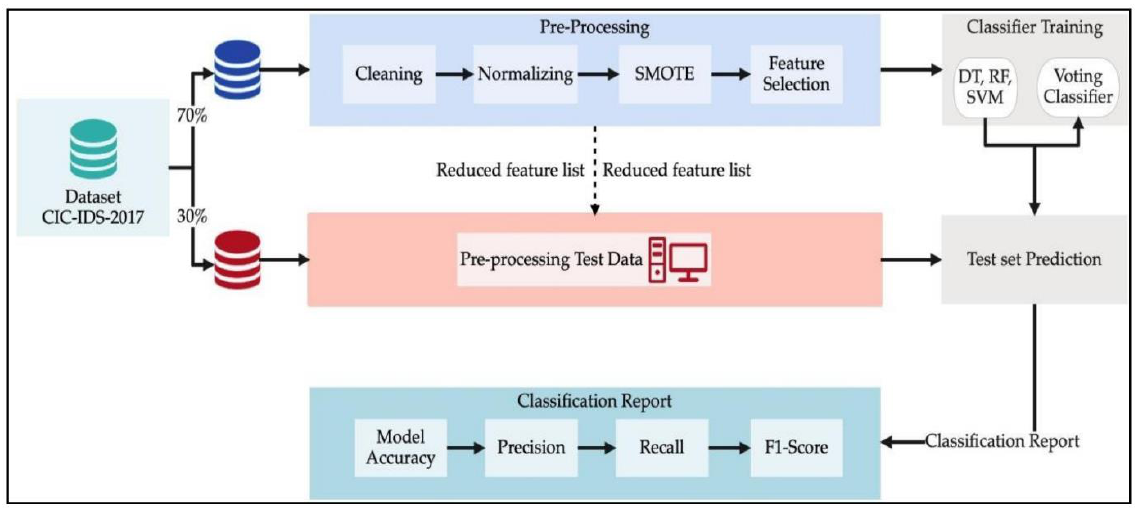
Figure 6. Pipeline model